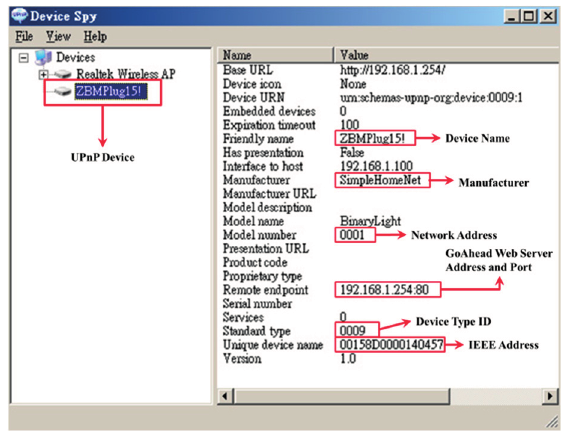
Figure 6. UPnP device